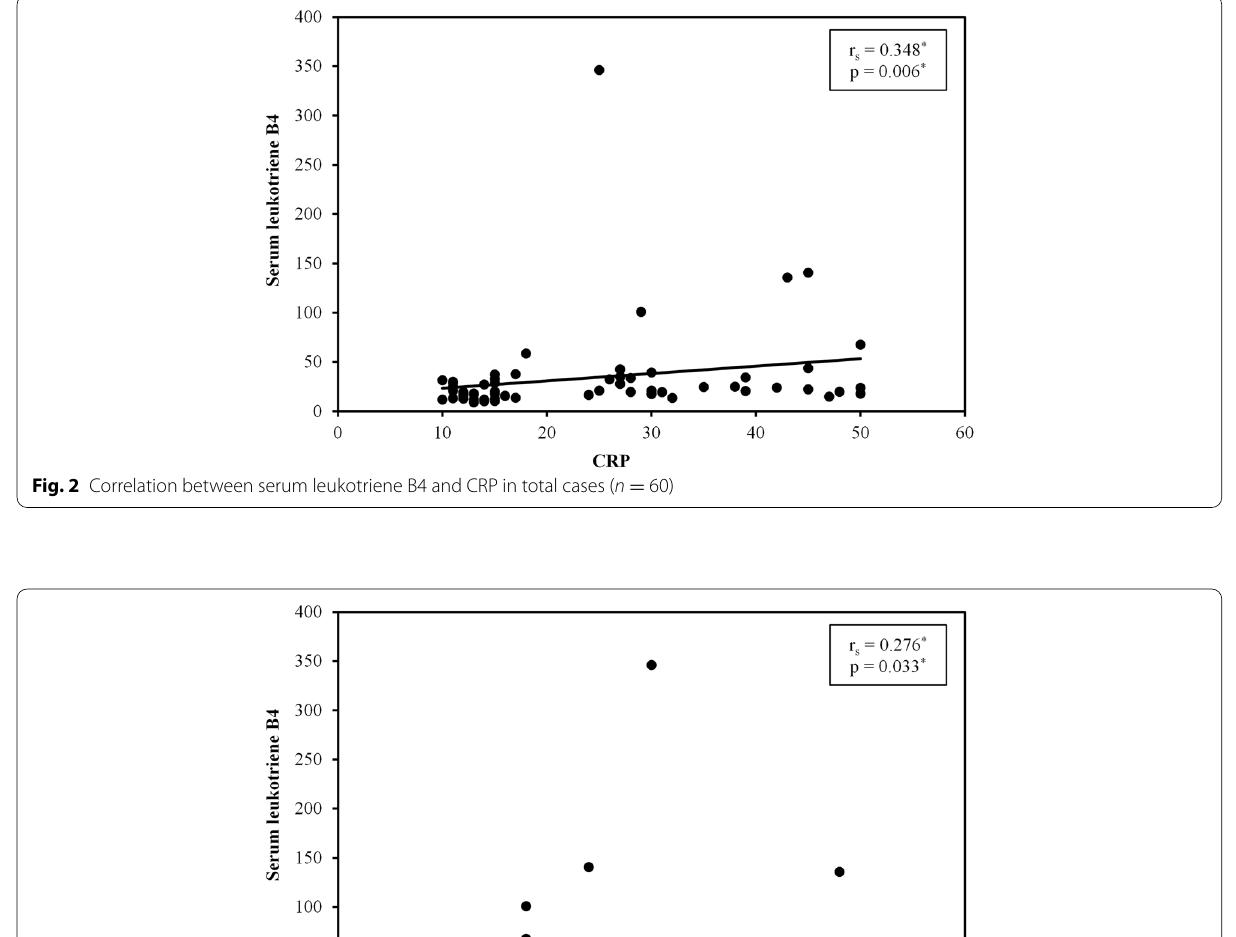
Fig. 3 Correlation between LTB4 and Child Score in cirrhotic patients ( n